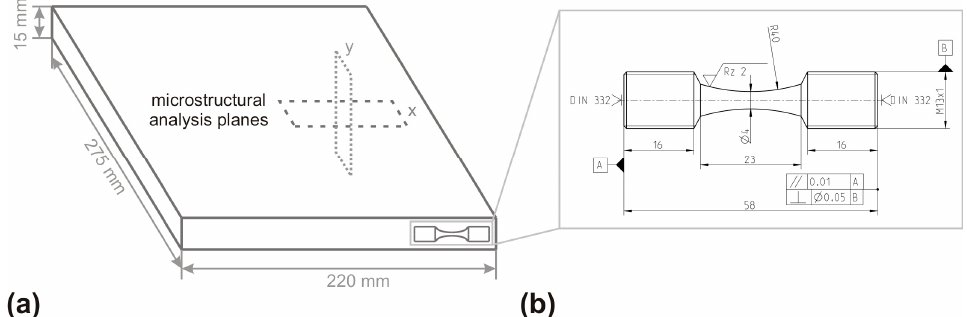
Figure 1. Schematic figure of the dimensions of the forged plate, the sample orientation of the axial specimens for tensile and fatigue testing and the investigated planes for the microstructural analysis ( a ) and the specimen geometry for fatigue testing ( b ).